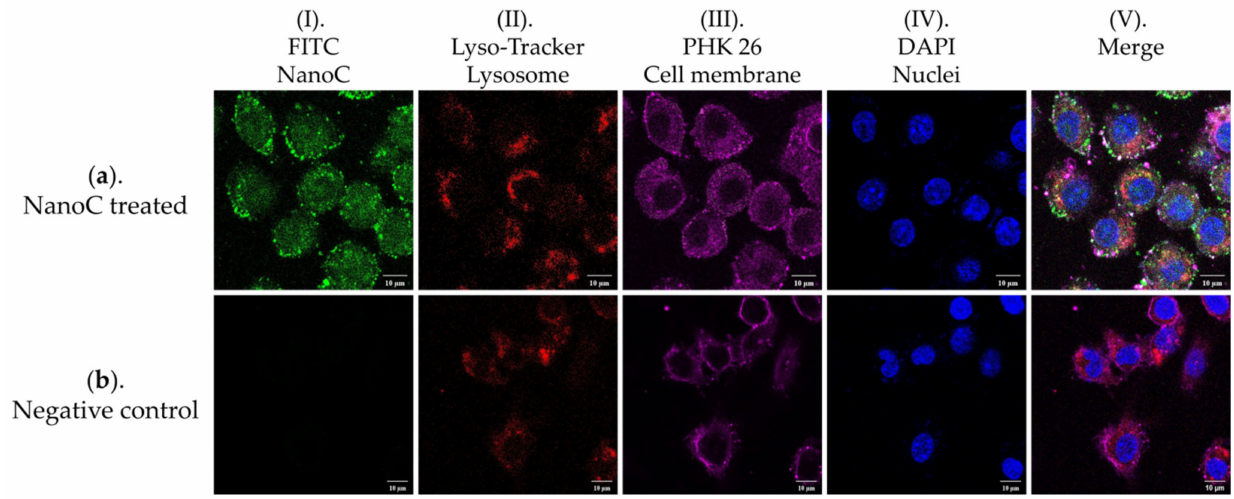
Figure 12. Confocal images of RAW264.7 cells treated by ( a ) FITC-loaded NanoC_72 6 h and ( b ) RAW264.7 without treatment as a negative control. ( I ) NanoC (FITC encapsulated, Green); ( II ) lysosome (Lyso-Tracker-labeled, deep red); ( III ) cell membrane (PKH 26-labeled, red); ( IV ) nuclei (DAPI-labeled, blue); ( V ) merge channel (scale bar = 10 µ